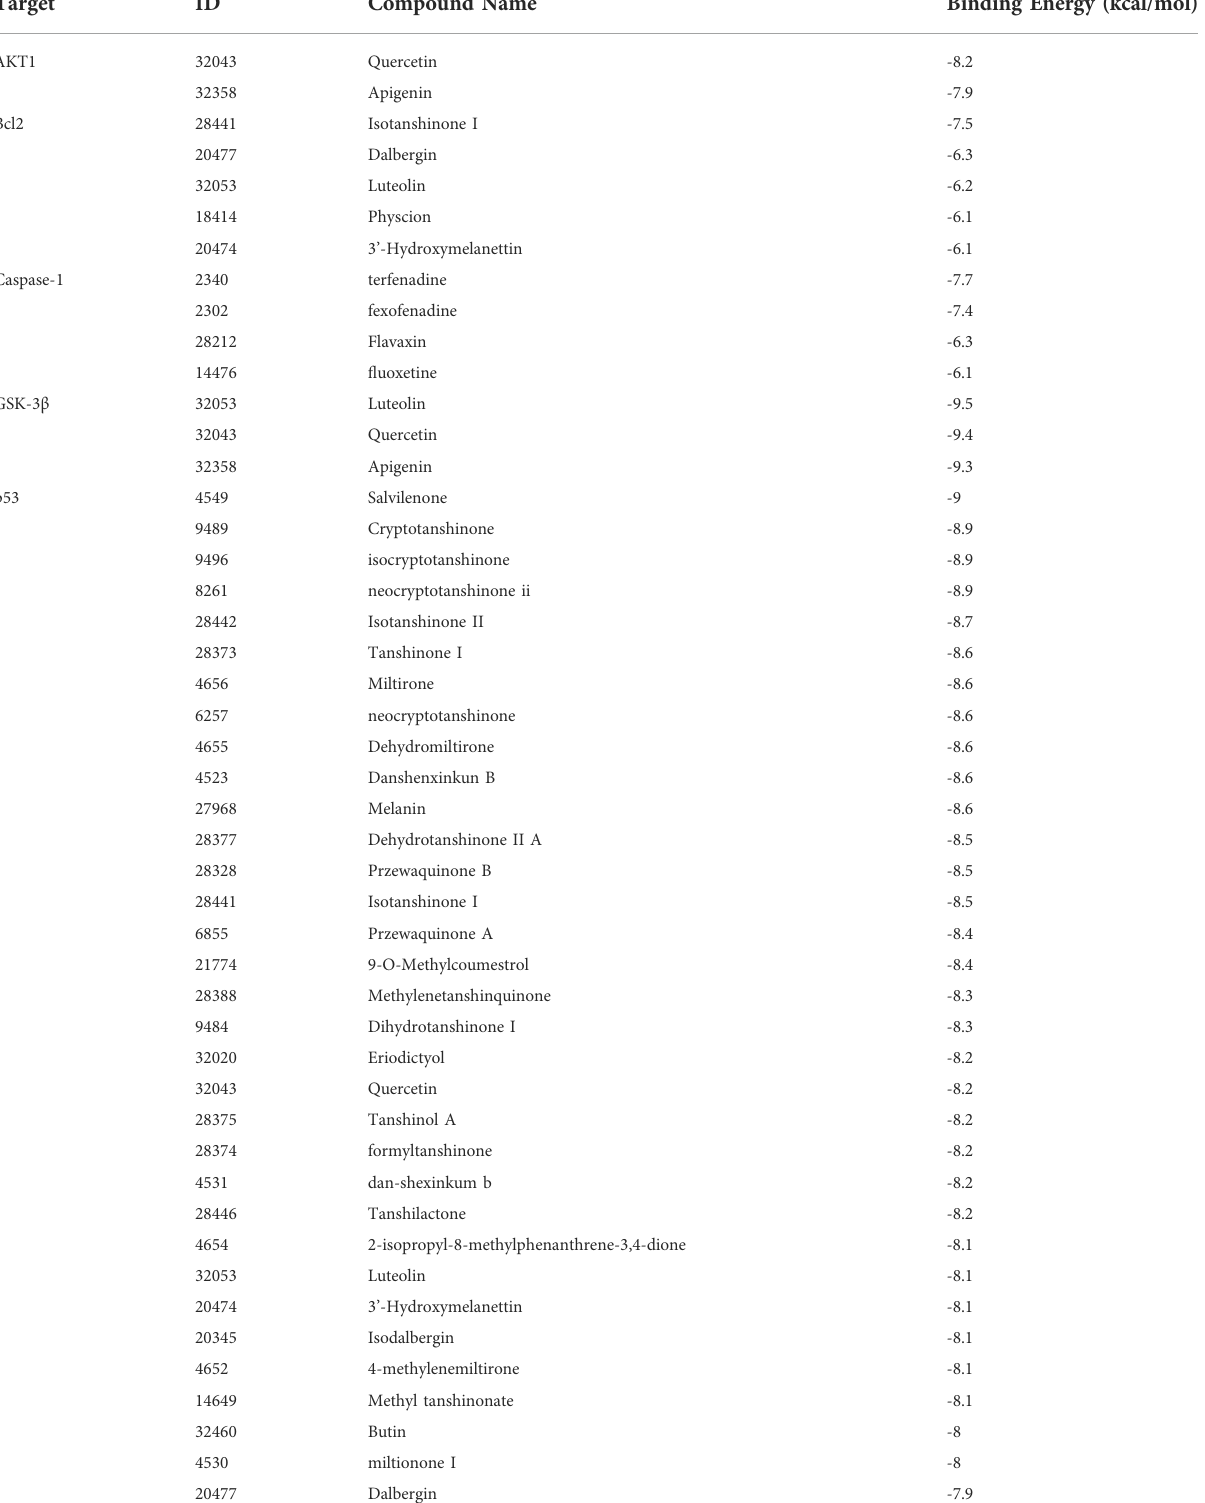
TABLE 1 Molecular docking. Through docking simulations, the docking results of QSYQ active molecule and core targeted proteins (AKT1, Bcl-2, Caspase-1, GSK-3 β and p53) were obtained. Lower binding energy indicates better molecular-docking binding effect.